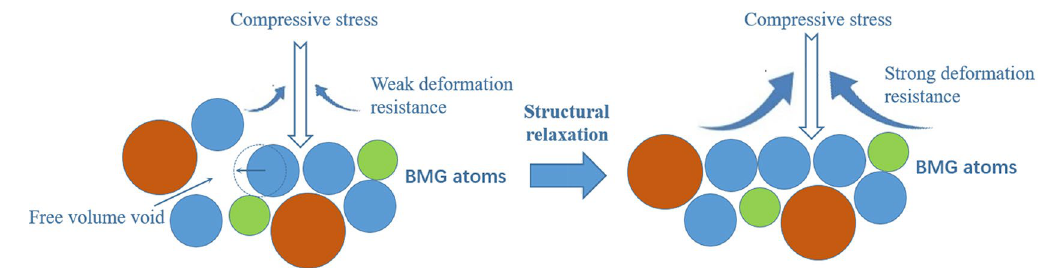
Figure 10. Diagram of structural relaxation strengthening